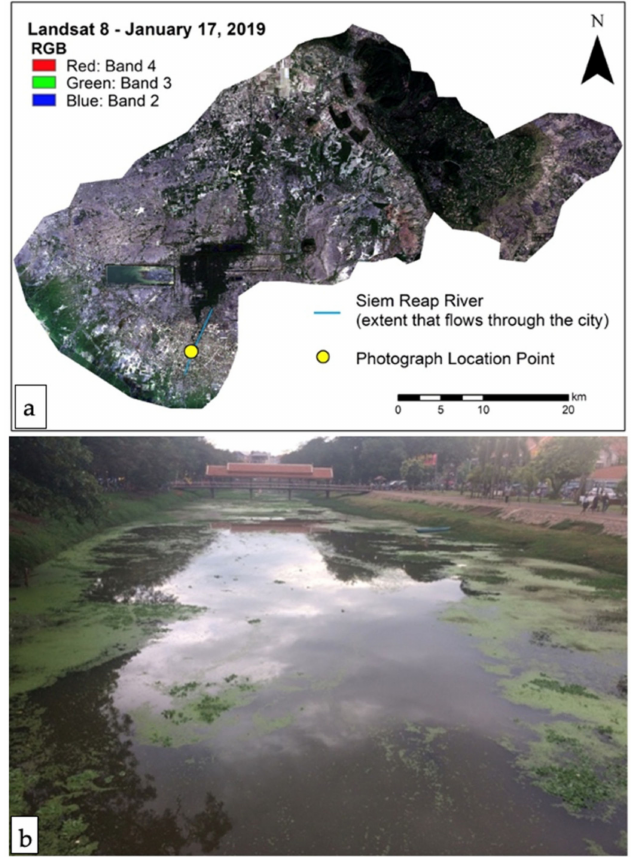
Figure 4. ( a ) Greater Angkor Region depicting the extent of the Siem Reap River in the city and the location of photograph 4b on the map ( b ) A photograph of the Siem Reap River in Siem Reap